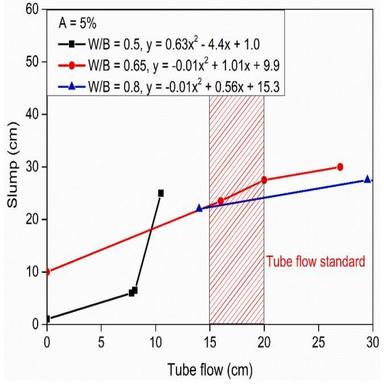
Relationship between CLSM slump and tube flow at a constant A of 5%.